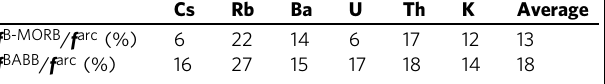
Slab fl ux averaged for all the elements are listed in the last column.